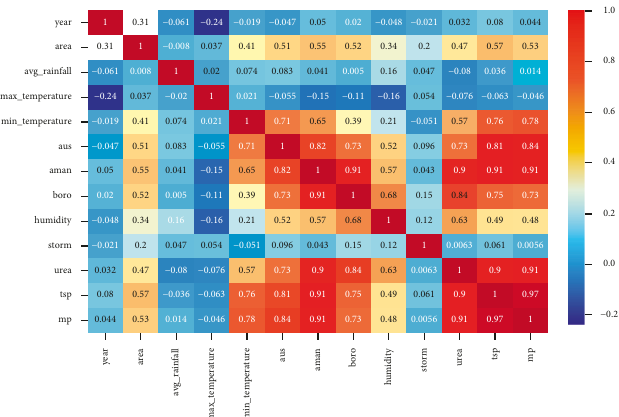
Figure 6: Partial heat map based on features